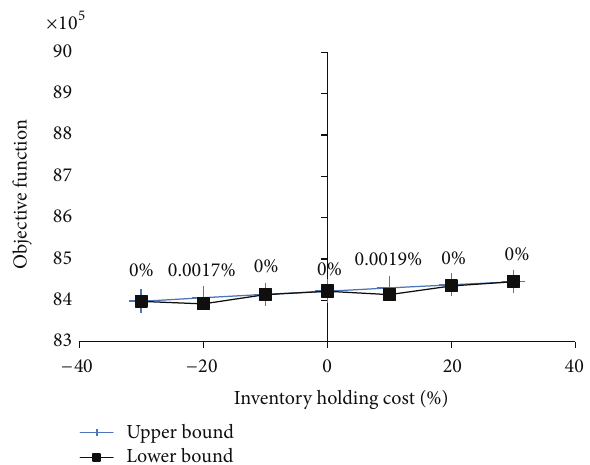
Figure 10: Sensitivity of objective function to changes in fixed installation cost for 15-node data sets.